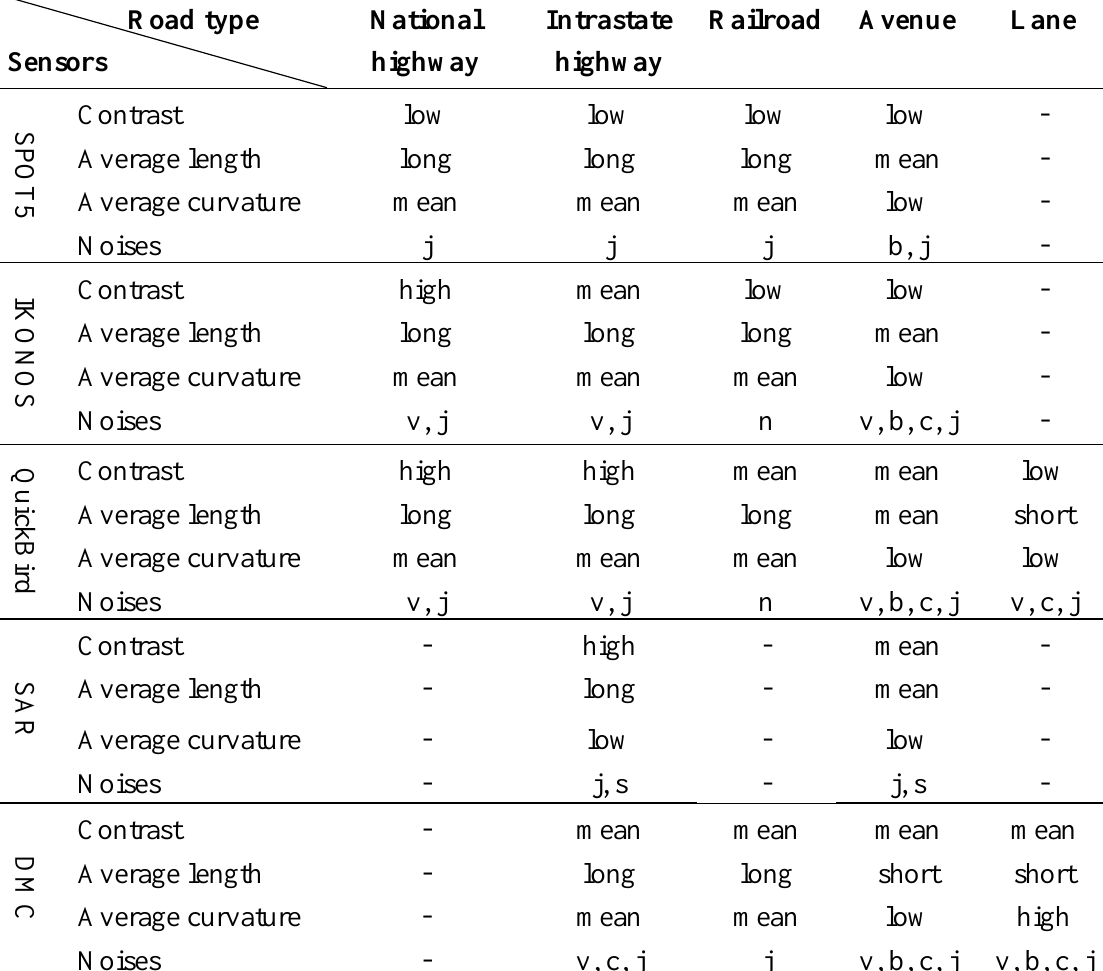
Table 1. Characteristics of the roads on the